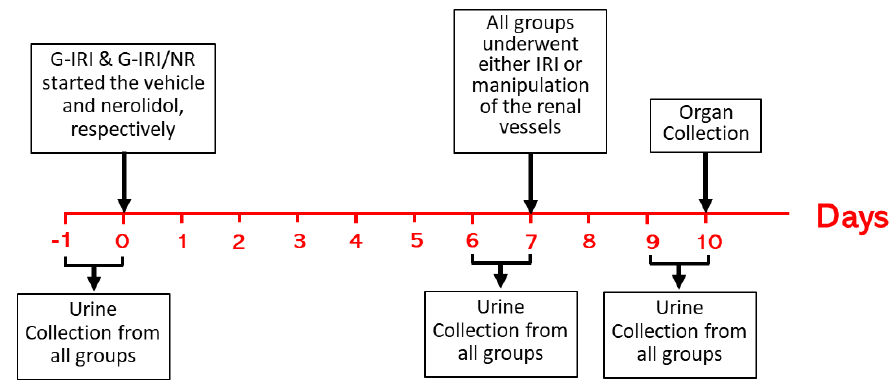
Figure 1. Schematic presentation of the study plan showing interventions in all groups.